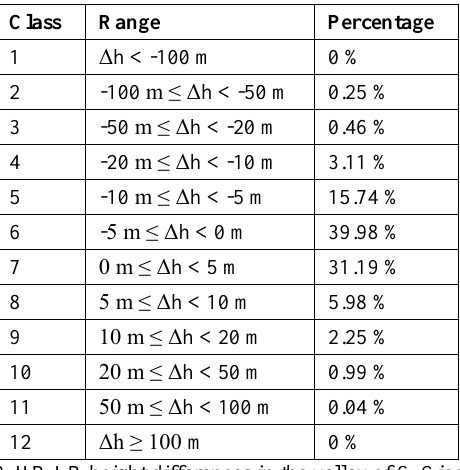
Table 3. HR-LR height differences in the valley of S.